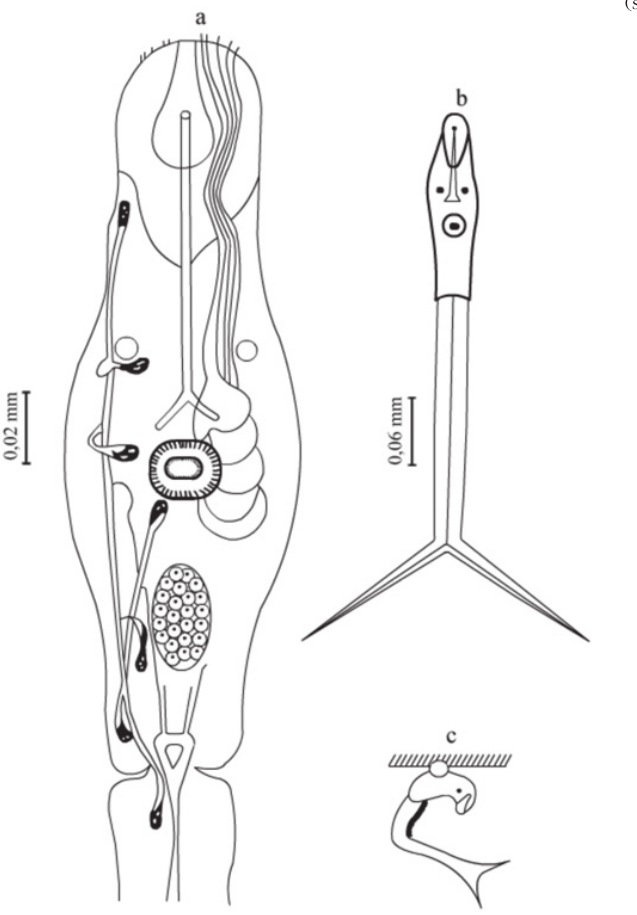
Fig. 4. – Dendritobilharzia loossi Skrjabin, 1924. a: details of the organs of cercaria; b: common view; c: resting posture. Parasite, 2011, 18 , 39-48